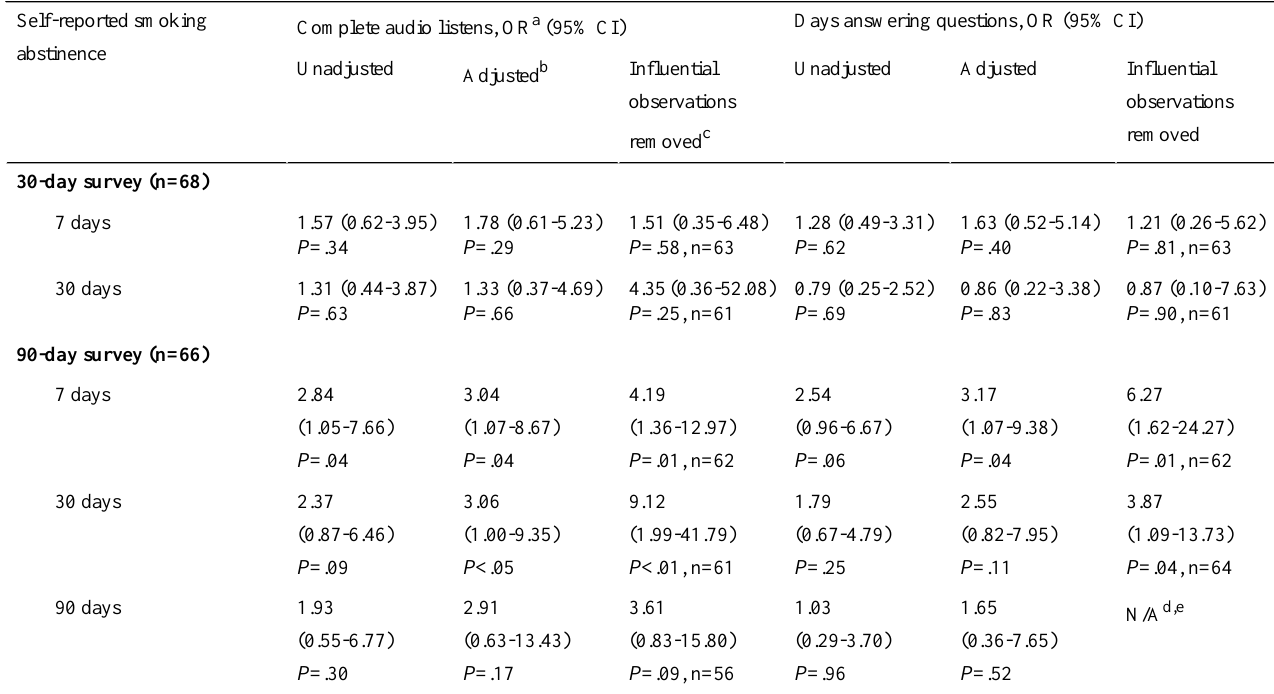
Table 4. Associations between app usage during the first 30 days and smoking cessation outcomes from 30- and 90-day surveys for full trial participants. To provide meaningful comparisons, estimates are given for the third versus first quartiles of the main exposures. Influential observations removed: Results of sensitivity analyses (adjusted